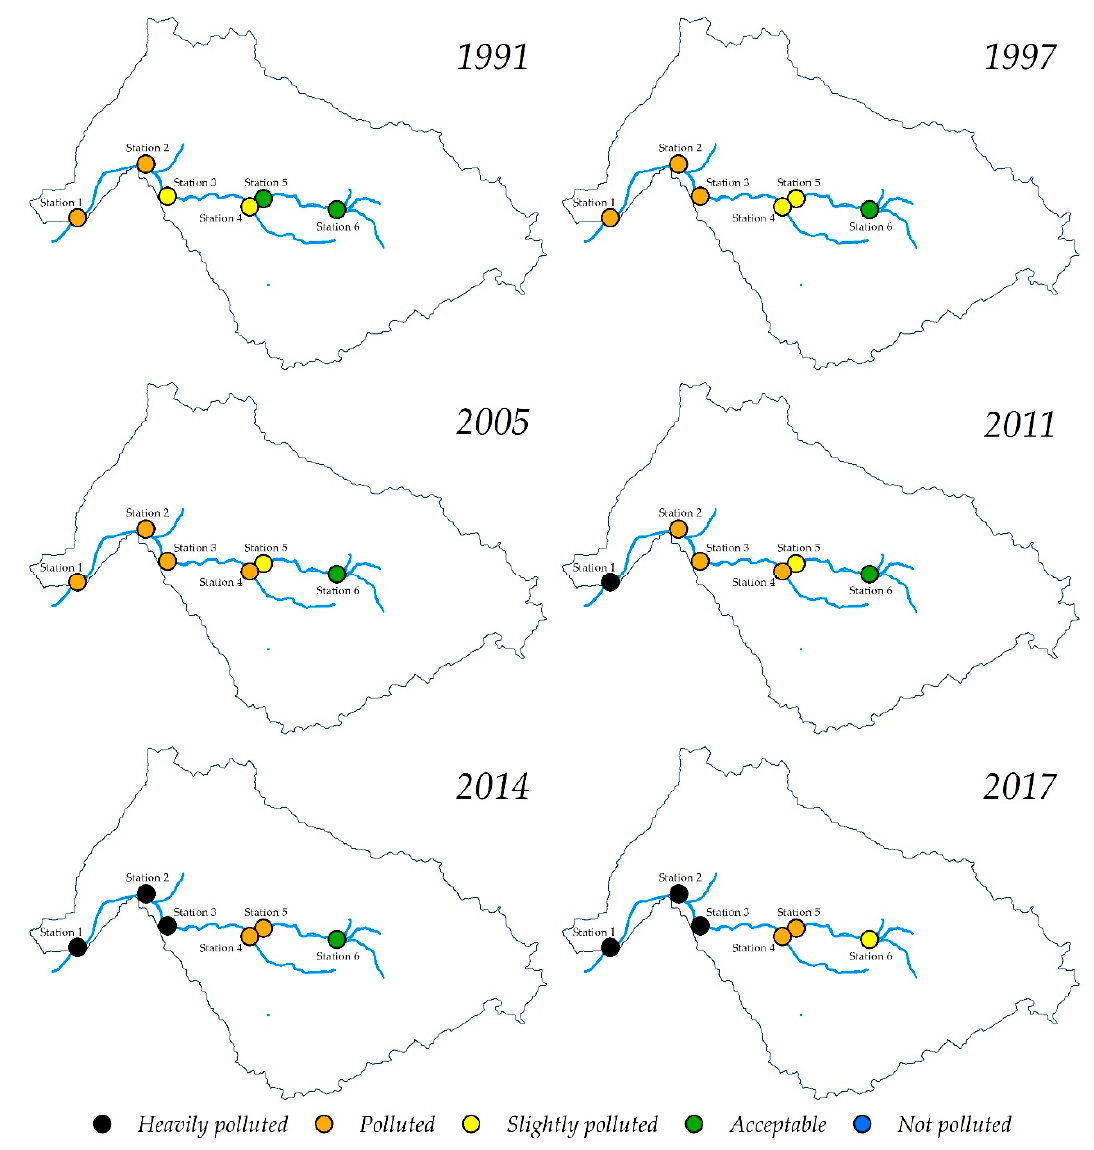
Figure 6. Water quality according to the National Sanitation Foundation-Water Quality Index (NSF-WQI) at measuring stations 1–6, including their corresponding upstream sampling sites, in 1991, 1997, 2005, 2011, 2014, and 2017.